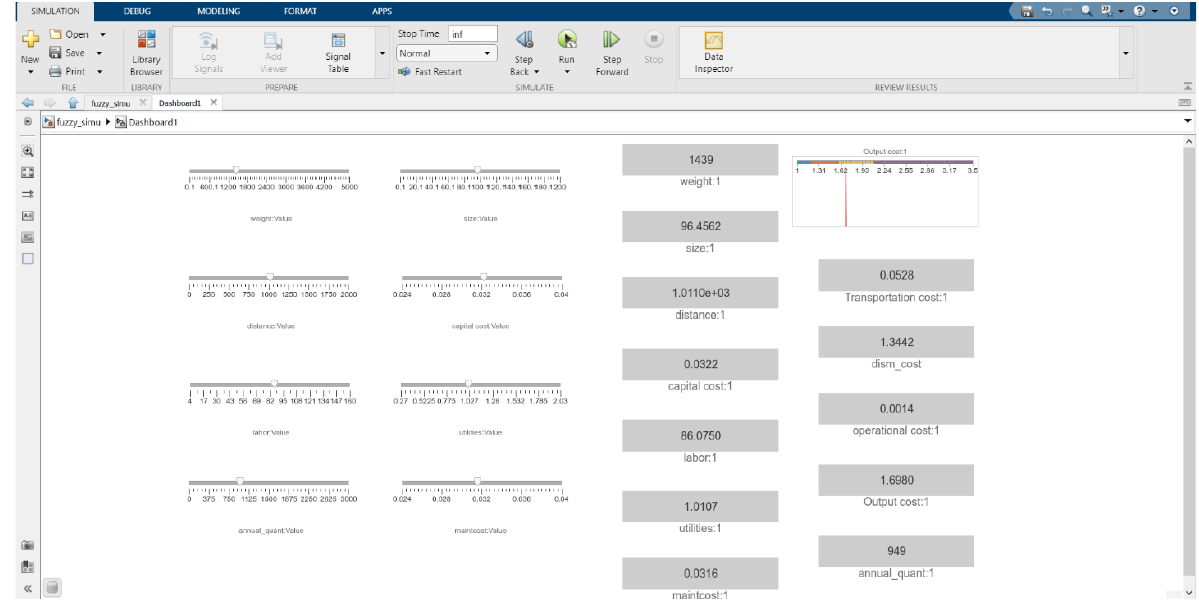
Figure 11. The user interface for selecting input parameters.